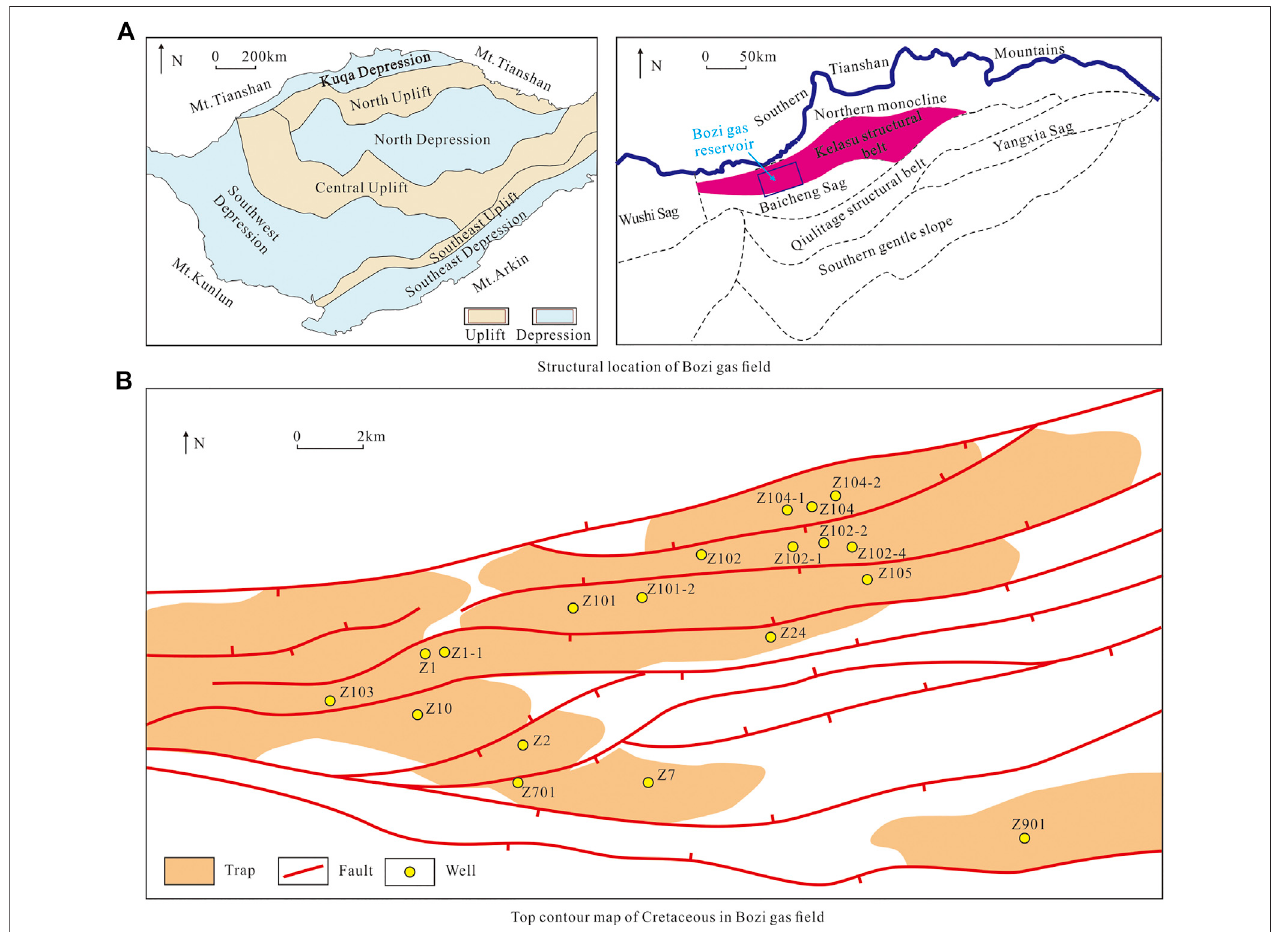
FIGURE 1 | (A) The Tarim Basin, located in the northwestern China, contains seven fi rst-order tectonic units: Kuqa Depression, Northern Tarim Uplift, Northern Depression, Central Uplift, Southwestern Depression, Southeastern Uplift, and Southeastern Depression. The Kuqa depression contains seven second-order tectonic units. The Bozi gas fi eld is located in the Kelasu structural belt, the second structural belt in Kuqa Depression. (B) The Cretaceous top contour map of the Bozi gas fi eld. The Bozi gas fi eld is a thrust structure complicated by faults, with many fault blocks and different sizes, and pop-up structures are developed in the middle. From north to south, the reservoir depth increases